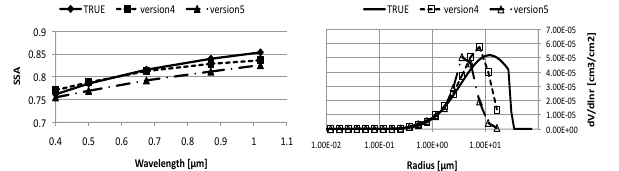
Fig. 9. Values of SSA (left panel) and SDF (right panel) for the cirrus contamination case. Solid, dashed, and dashed-dotted lines represent true values, retrieved values from version 4, and retrieved values from version 5,